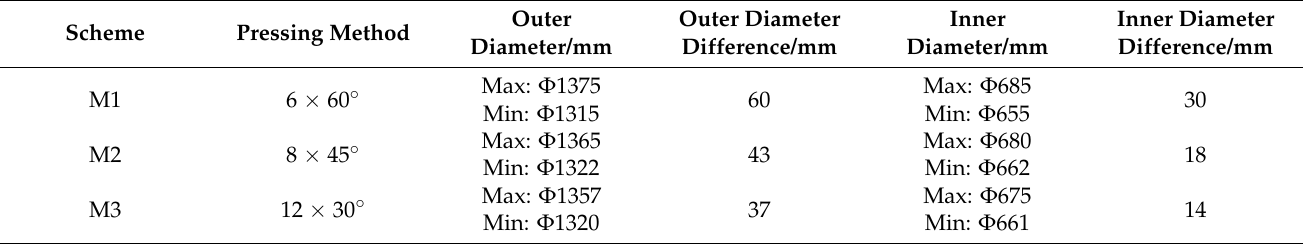
Table 3. Different rotation angle